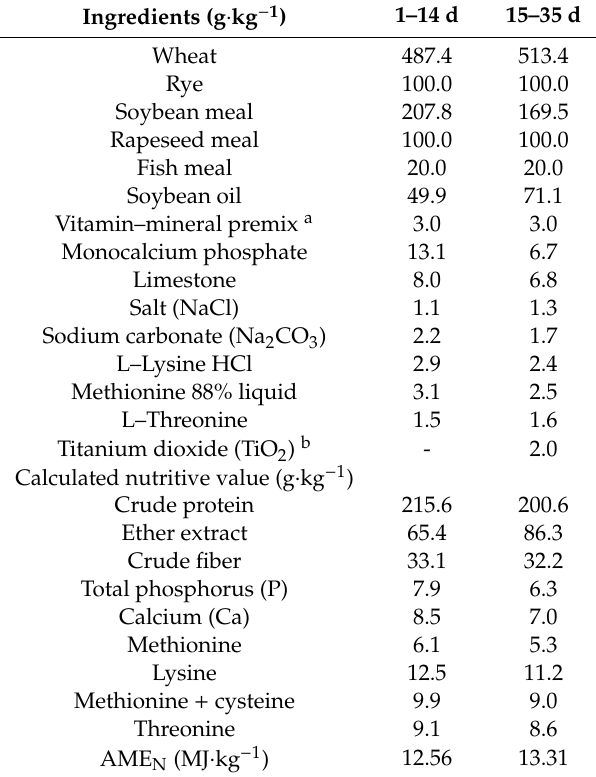
Table 1. Composition of the experimental basal